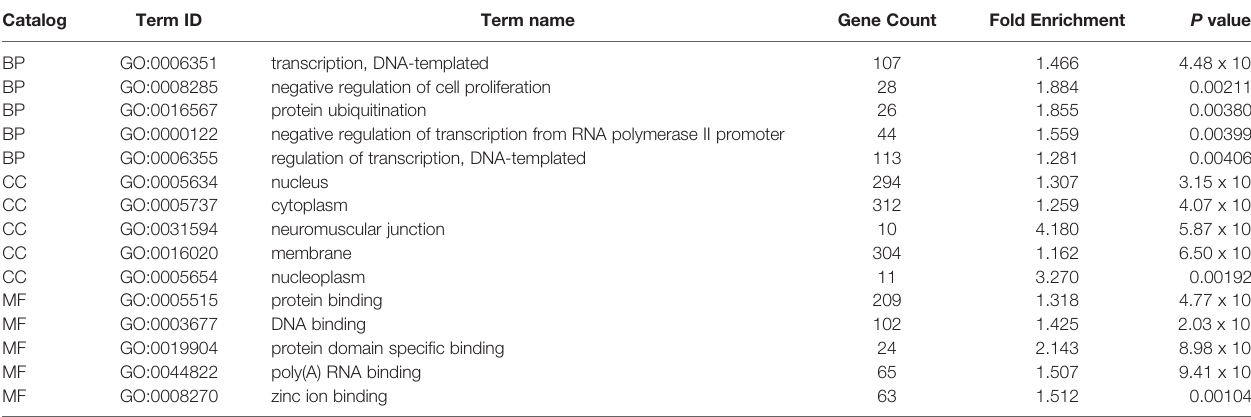
TABLE 3 | The enriched GO terms with differentially methylated genes in DIO-CD offspring vs NC-CD offspring ( P <